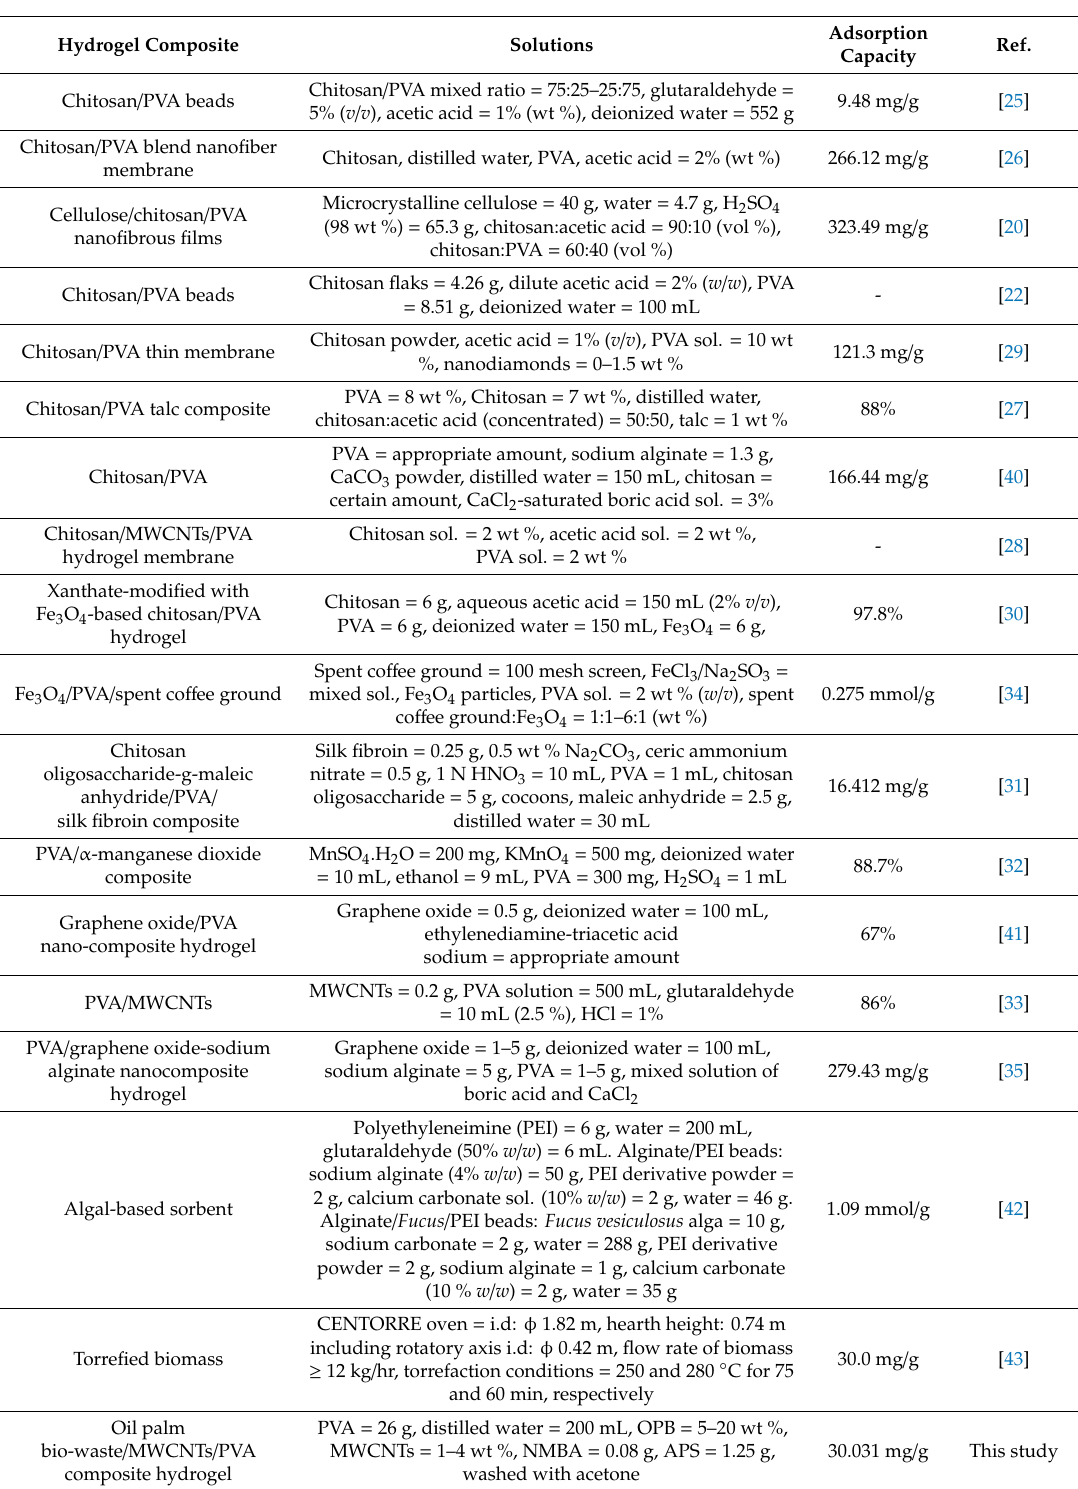
Table 1. Di ff erent types of polyvinyl alcohol (PVA) hydrogel loaded composites as adsorbents used for the adsorption of